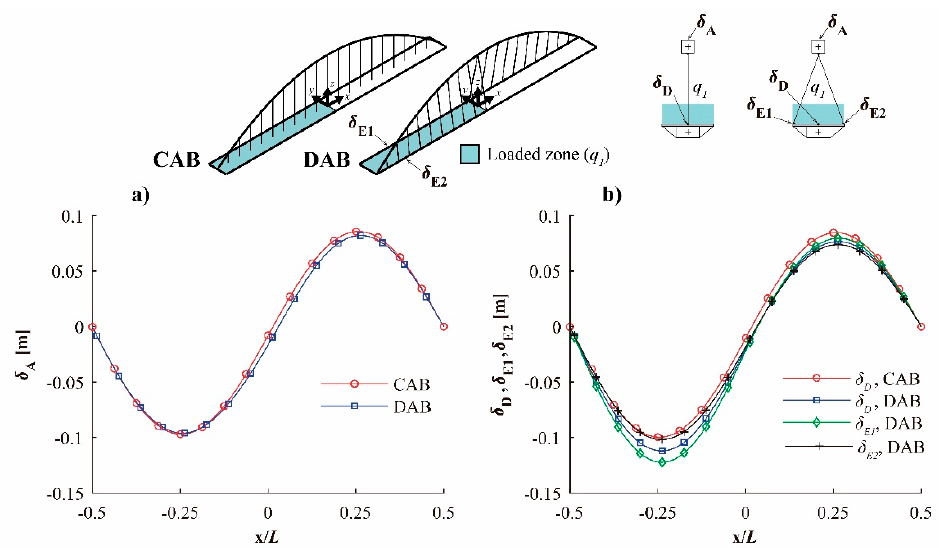
Figure 31. Deflections under q 1 load at the arch ( a ) and the deck ( b ).